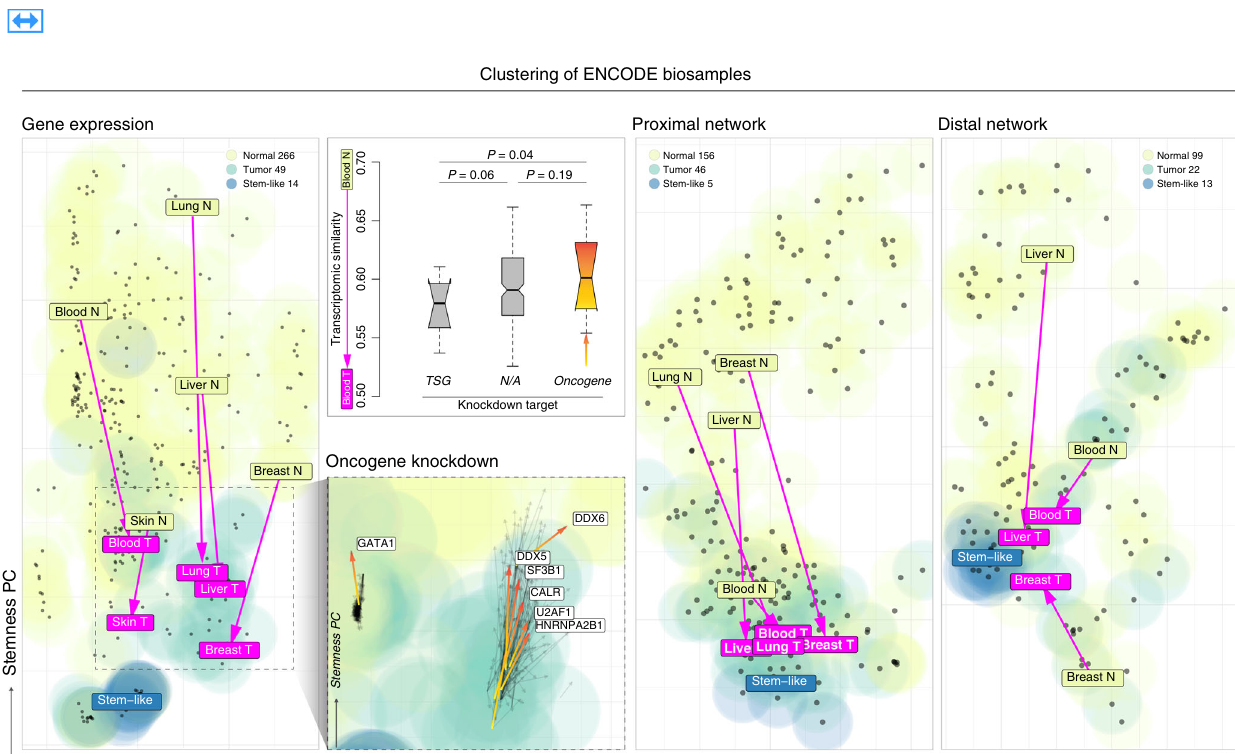
Fig. 4 Oncogenic transformation and cell state. We project the expression pro fi les (left, poly-A long RNA-seq), proximal network (second from right, CTCF ChIP-seq), and distal network (right, candidate cis-regulatory elements) of the ENCODE cell types to a lower dimension space. Stem-like cell types formed a cluster, suggesting stem-like cell types have a distinct pro fi le from normal and cancerous cell types. Further, we fi nd that cancerous cell types tend to locate closer to stem-like clusters. Oncogene knockdown in K562 led to more transcriptomic similarity to a normal cell-type, and tumor suppressor gene (TSG) knockdown led to greater similarity to a tumor cell-type (second from left, top, in comparison to GM12878). In general, we fi nd that oncogene knockdown leads to a slight reversion towards normal state along the stem-like component (second from left,